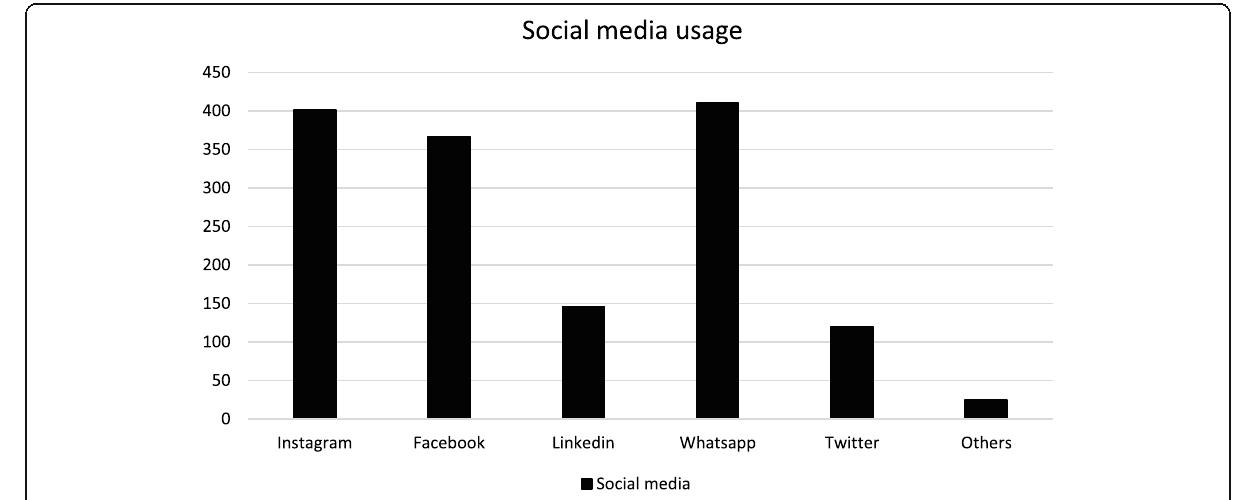
Fig. 1 Distribution about social media usage of all